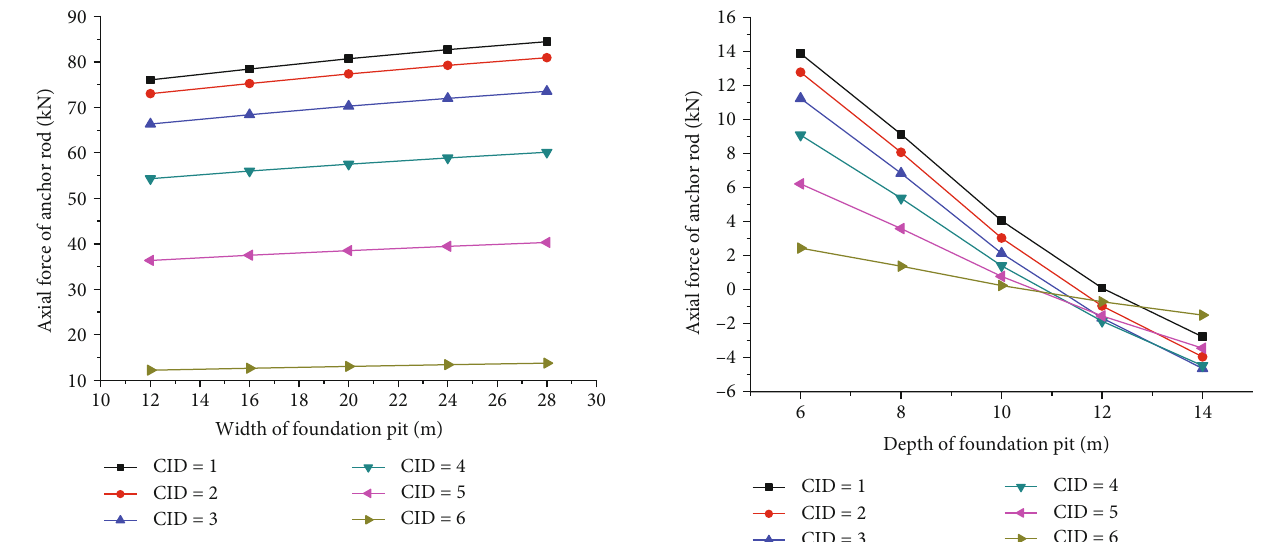
Figure 13: Variation curve of axial force of each member of the leftmost anchor bolt in a 20m wide tunnel with foundation pit depth.